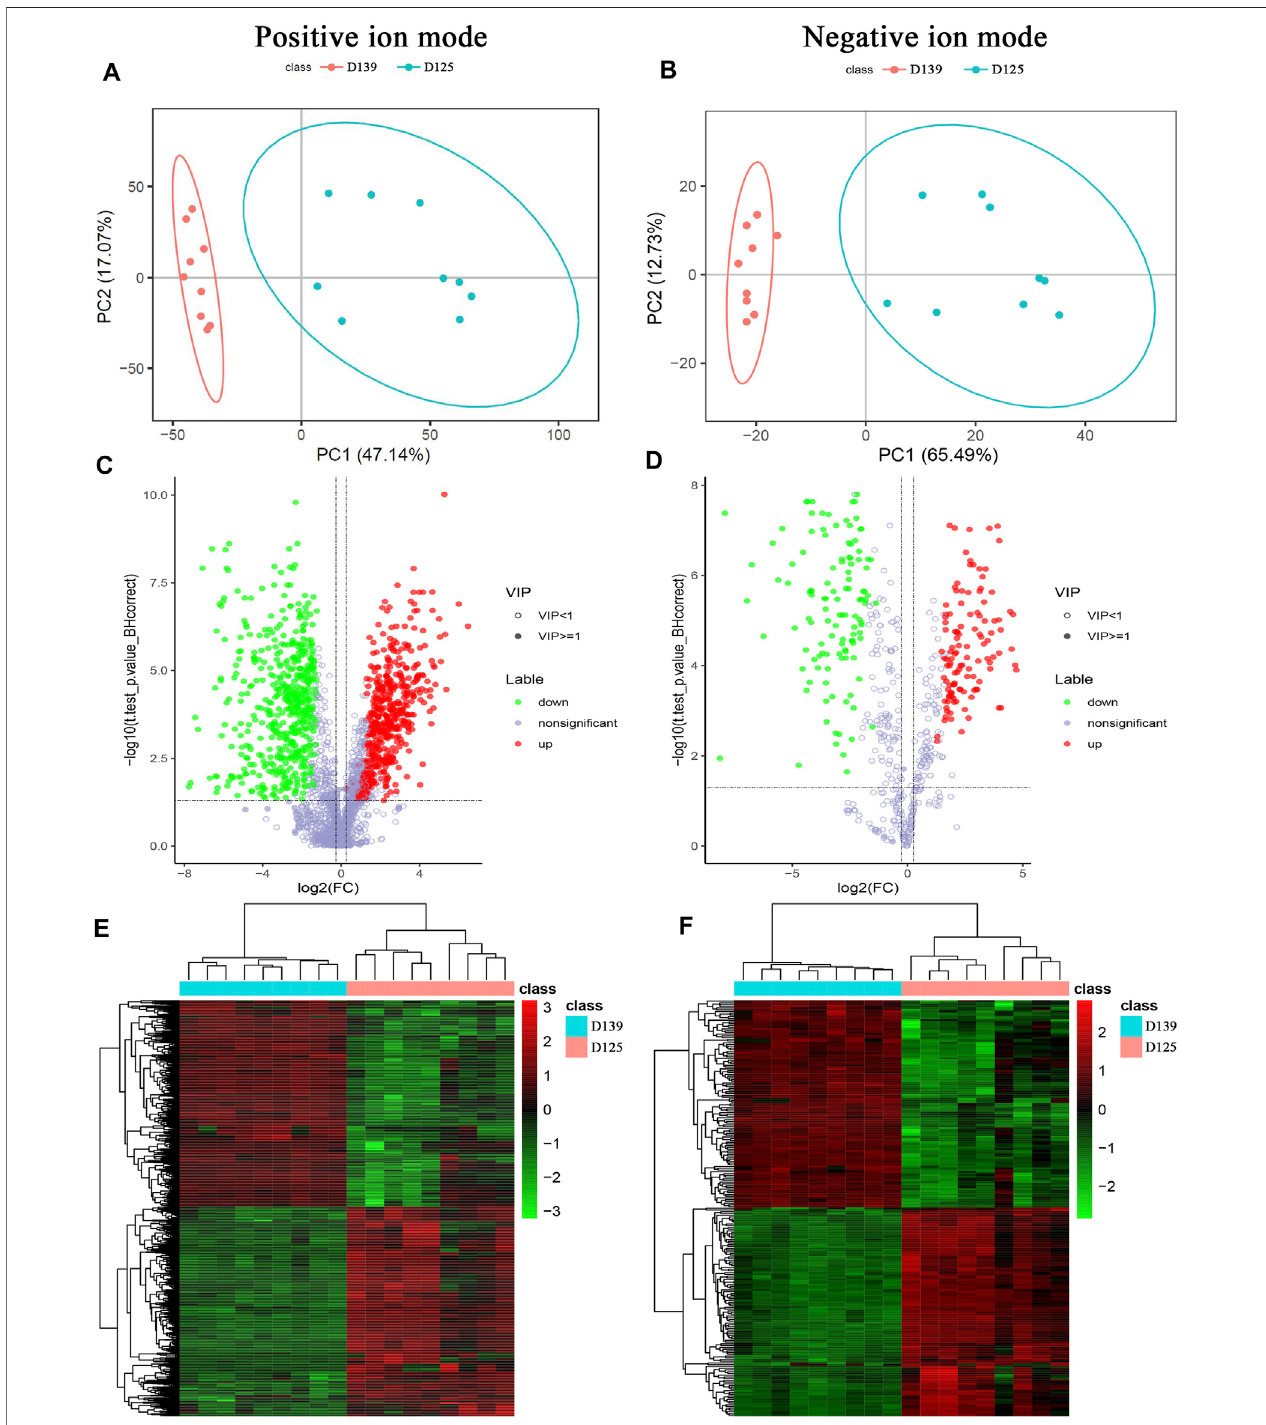
FIGURE 4| Characterization of differential metabolites (DMs) identi fi ed by positive and negativeion mode between sexually mature and immature chicken ovaries. (A,B) PCA distribution of 18 samples. (C,D) DMs identi fi ed by positive and negative ion mode were presented in a volcano plot. (E,F) The hierarchical cluster analysis of